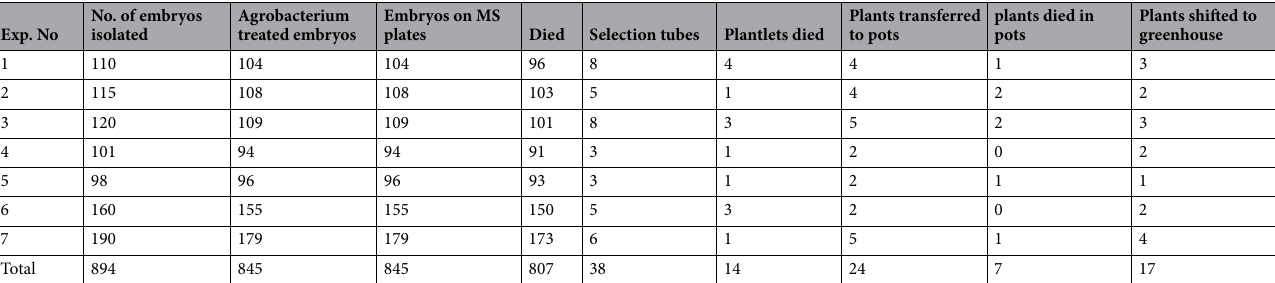
Table 1. Numerical data for transformation experiments.